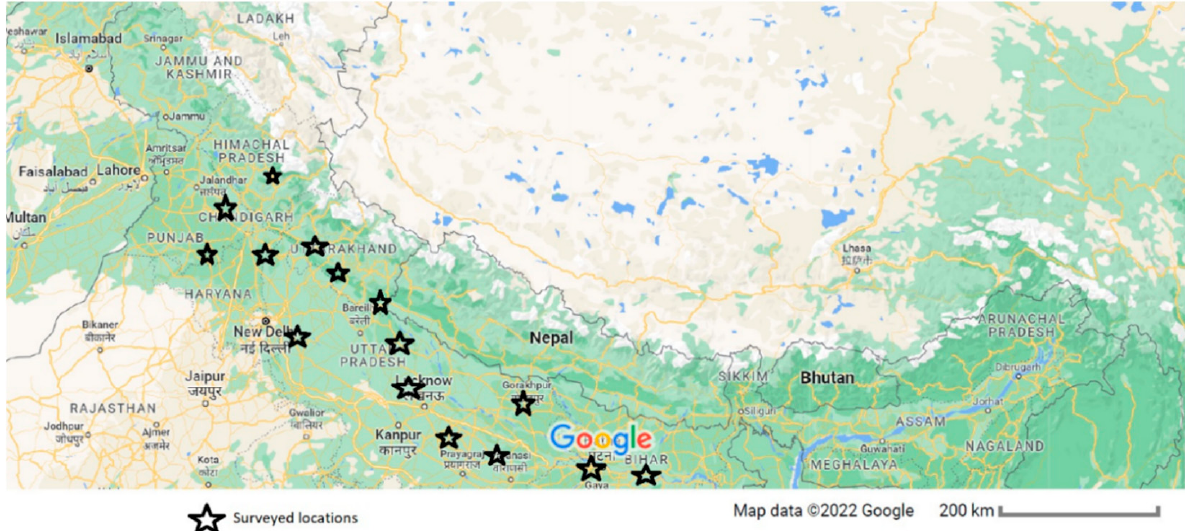
Figure 1. A map showing surveyed area for the collection of leaf blight samples of wheat in India.